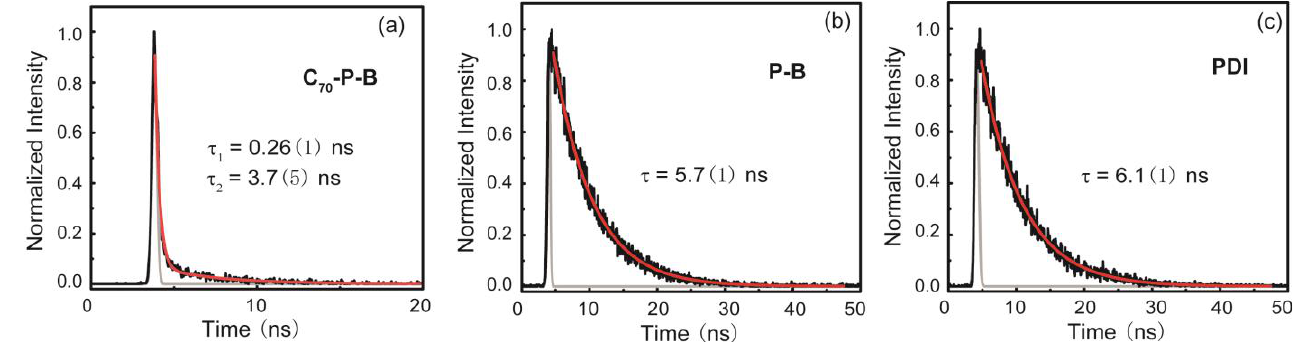
Figure 4. Fluorescence decay traces obtained with a time-correlated single photon counting (TCSPC) of ( a ) C 70 -P-B , ( b ) P-B and ( c ) PDI in toluene. They were excited at 510 nm and recorded at 600 nm. The gray lines are the instrument response profiles, black lines are the raw data, and the red lines are the fitting curves. The brackets represent the error of fitting.